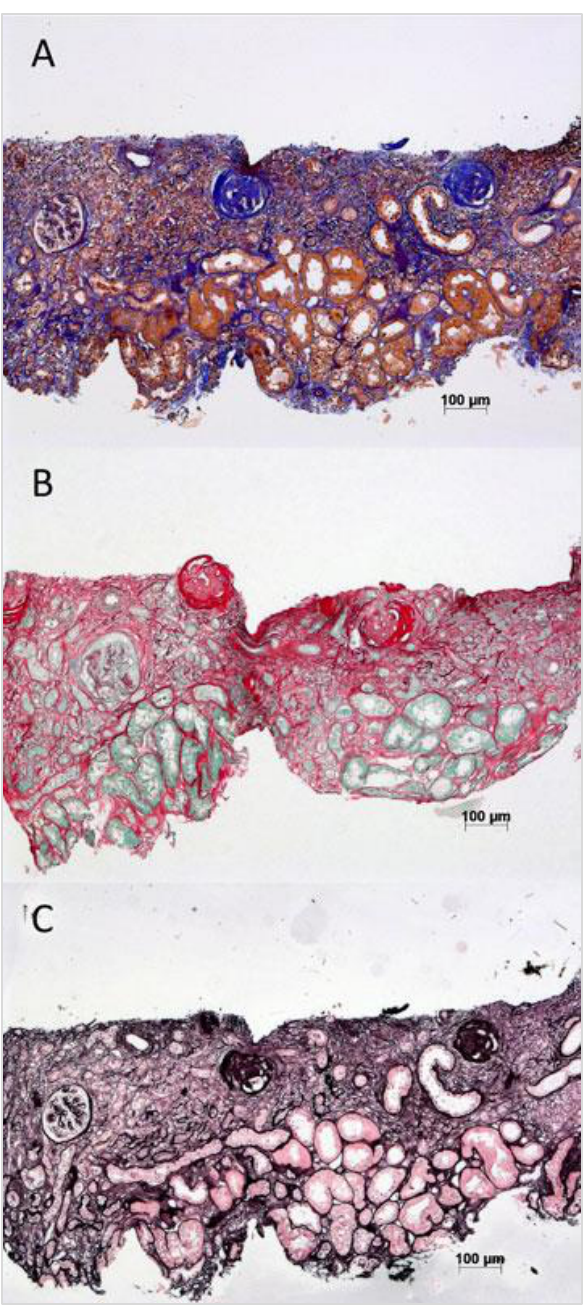
Figure 1: Examples of commonly used stains for histological assessment of renal interstitial fibrosis. (A) Trichrome. (B) Sir- ius red. (C) Silver